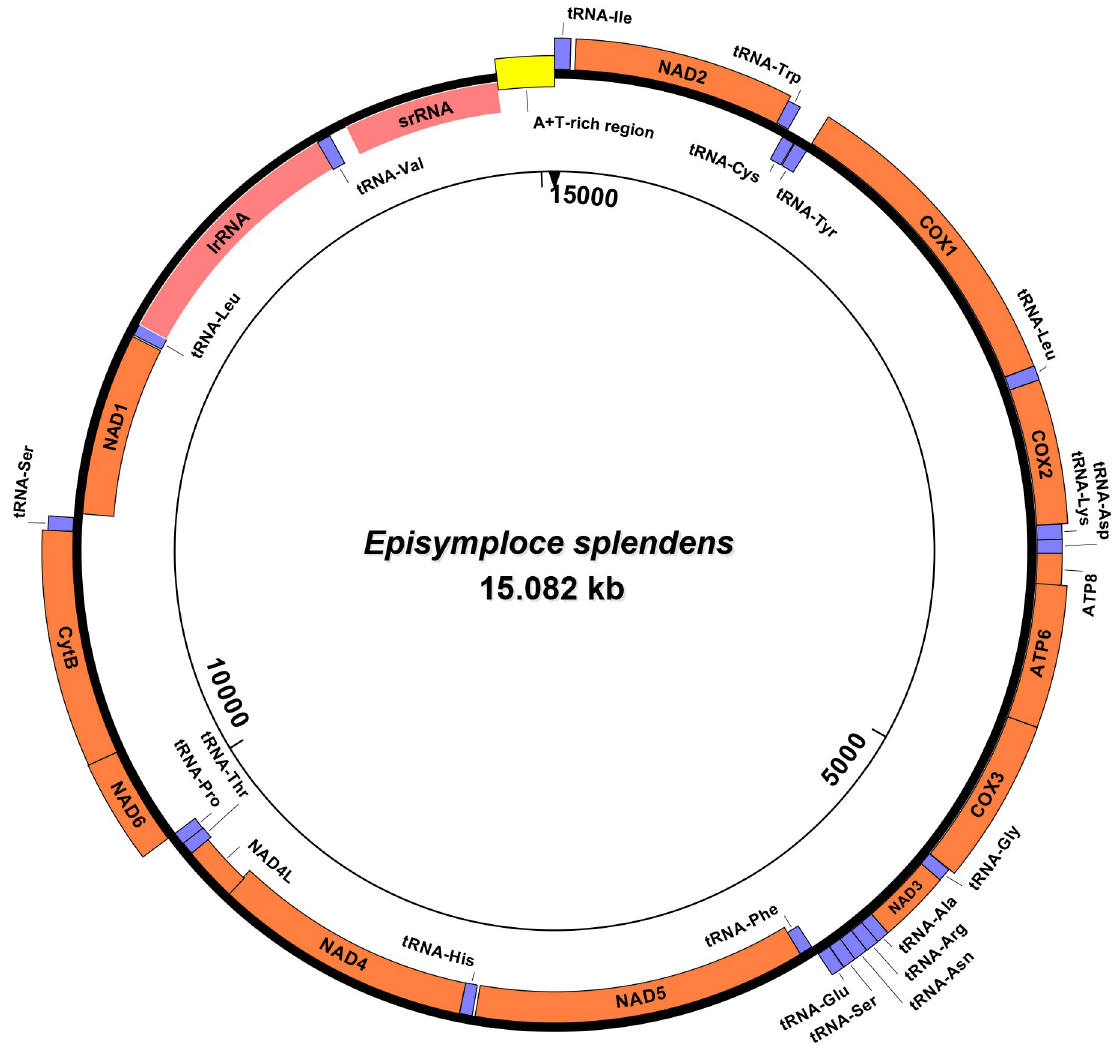
Fig 1. Circular gene map of Episymploce splendens mito-genome. Genes coded in the J-strand are inside of the circle. Gene coded in the N-strand are outside of the circle. COX1 , COX2 and COX3 refer to the cytochrome C oxidase subunits; CytB refers to cytochrome B; ATPase6 and ATPase8 refer to ATP synthase subunits 6 and 8 genes; and NAD1 - NAD6 and NAD4L refer to the NADH dehydrogenase subunit 1–6 and 4Lgenes.